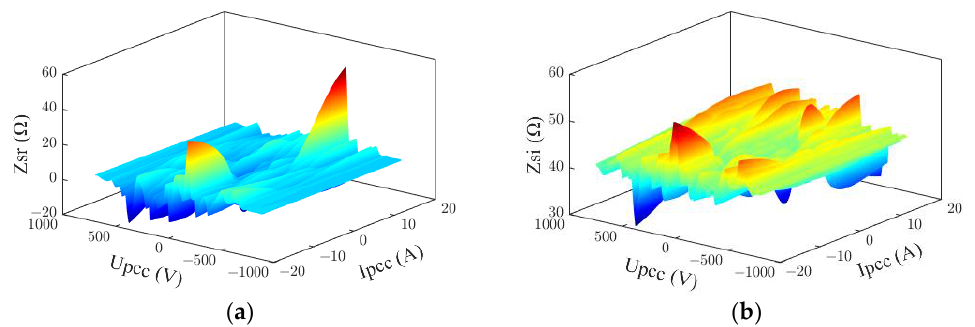
Figure 22. Results of method 2 in 7th harmonic. ( a ) Real part; ( b ) Imaginary part. Table 9. Evaluation indexes of method 2 in 7th harmonic.